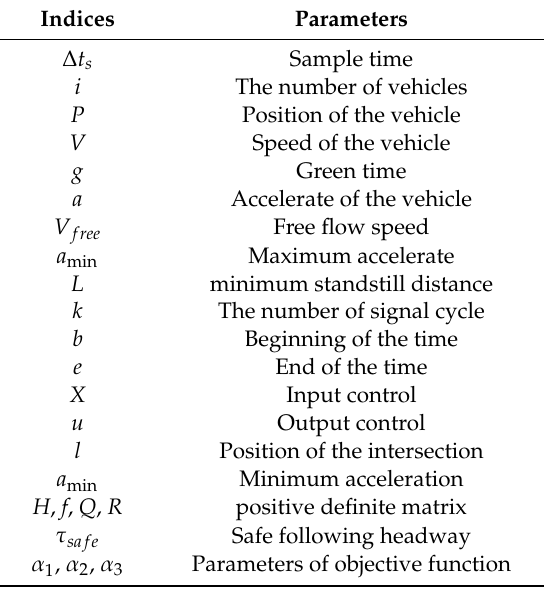
Table 2. Parameters and indices for model formulation.